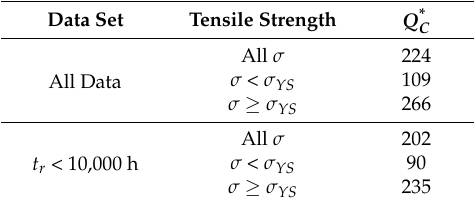
Table 3. Inconel 617 Q ∗ values (kJ/mol) determined using Arrhenius plots. C